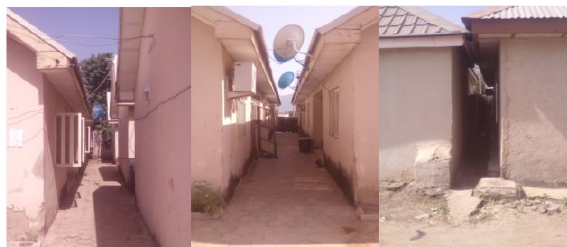
Figure 3. Windows of houses opening into a narrow lobby with insufficient setbacks between buildings, causing insufficient airflow for adequate ventilation.